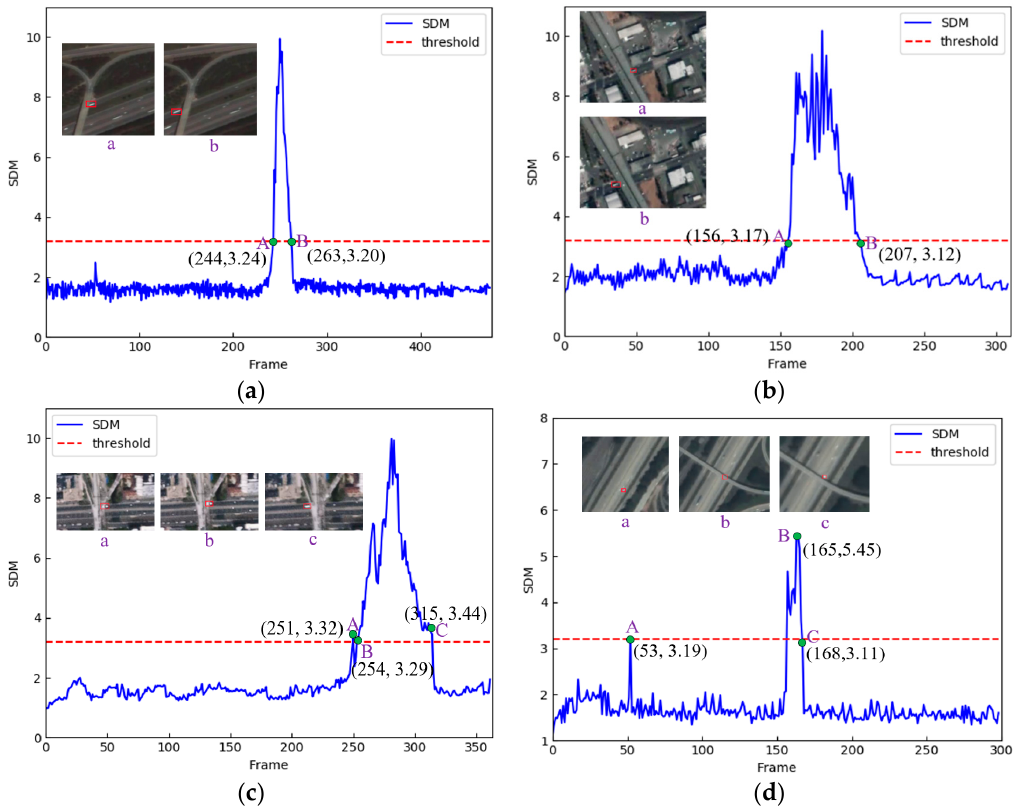
Figure 11. Visualization of some tracking results for the occluded object. The data in the parenthesis marked by upper case letters denote the current frame’s SDM value of the images with the corre- sponding lower case letters. ( a ) Occlusion process of Car3 sequences. ( b ) Occlusion process of Car4 sequences. ( c ) Occlusion process of Car5 sequences. ( d ) Occlusion process of Car6 sequences.